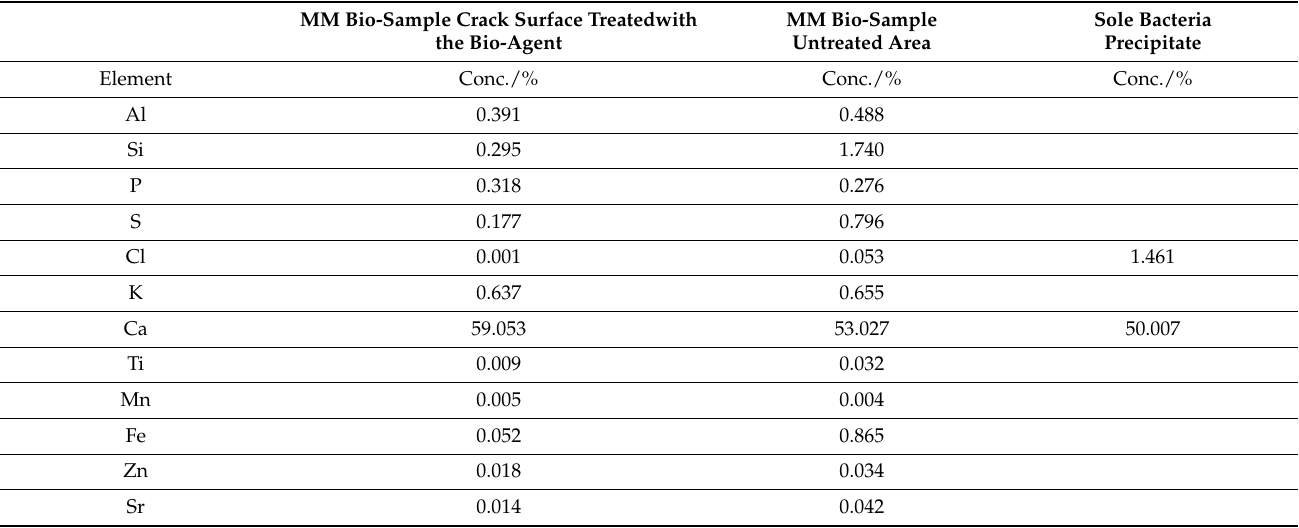
Figure 10. SEM analysis of MM bio-samples (precipitate formed in cracks) after 150 days of incuba- tion [23]. Table 6. Results of the comparative XRF